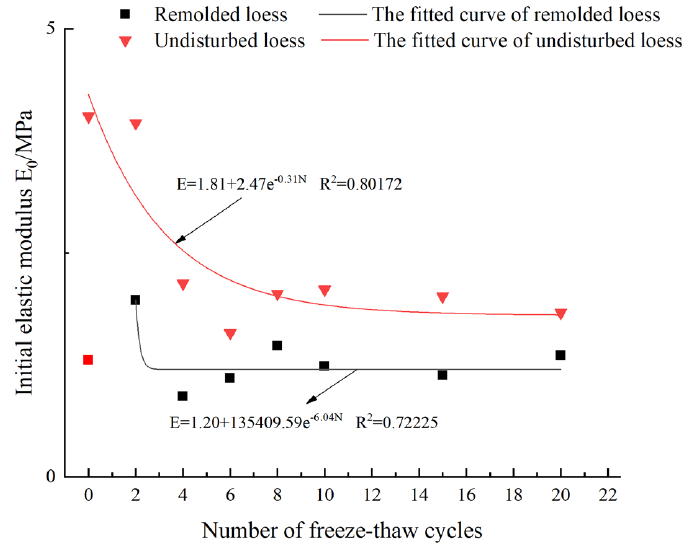
Figure 12. Relationship between the initial elastic modulus of loess and the number of freeze–thaw cycles.